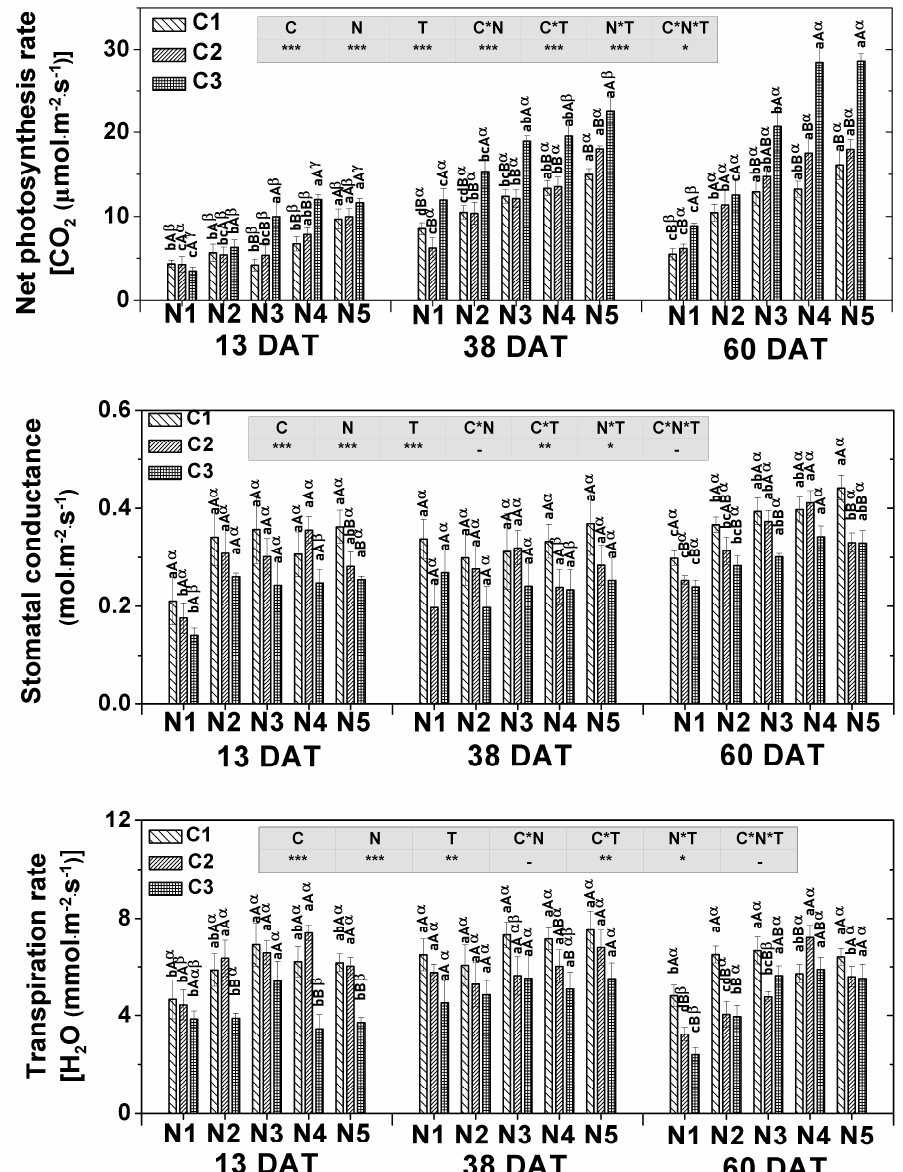
Figure 1. Net photosynthesis rate, stomatal conductance, and transpiration rate of cucumbers grown under di ff erent N and [CO 2 ] levels at three growth stages ( n = 6). Bars represent standard errors. CO 2 levels: C1, C2, and C3: 400, 625, and 1200 µ mol mol − 1 . N levels: N1, N2, N3, N4, and N5: 2, 4, 7, 14, and 21 mmol L − 1 . Means not followed by the same lower case letters are significantly di ff erent among different N levels in the same CO 2 level and growth stage, and not followed by the same upper case letters are significantly different among different CO 2 levels in the same N level and growth stage, and not followed by the same Greek letters are significantly different among different growth stages in the same CO 2 and N level, according to Duncan’s test at p < 0.05. In the internal table, C: [CO 2 ] level; N: N level; T: growth stage. Asterisks (*) indicate significant di ff erences (* p < 0.05; ** p < 0.01; *** p < 0.001); - indicates non-significant di ff erences ( p ≥